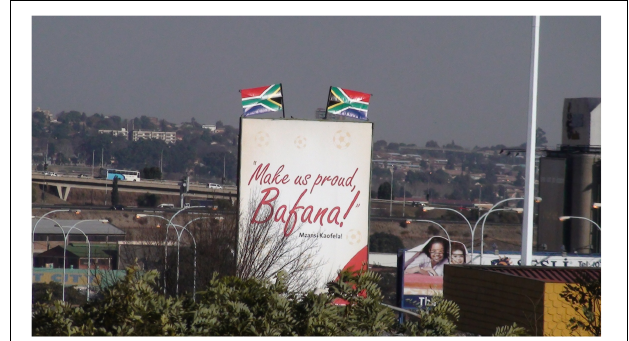
FIGURE 10 | Newspaper headline the day after the opening game of the 2010 World